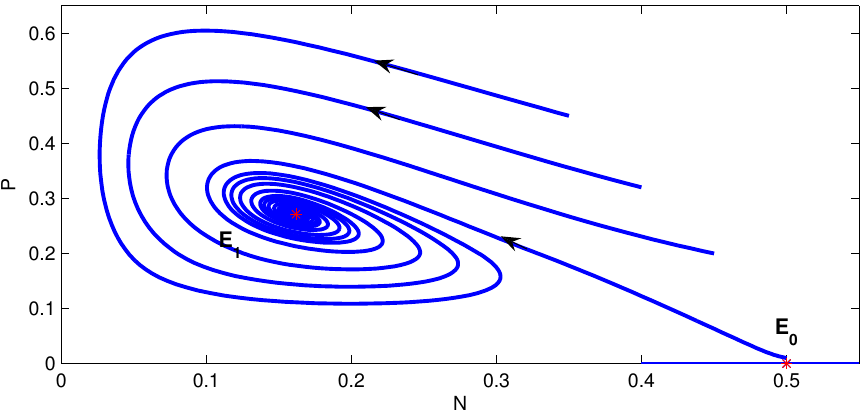
Figure 5. The phase portrait of model Equation (3) when E 1 is locally asymptotically stable and E 0 is